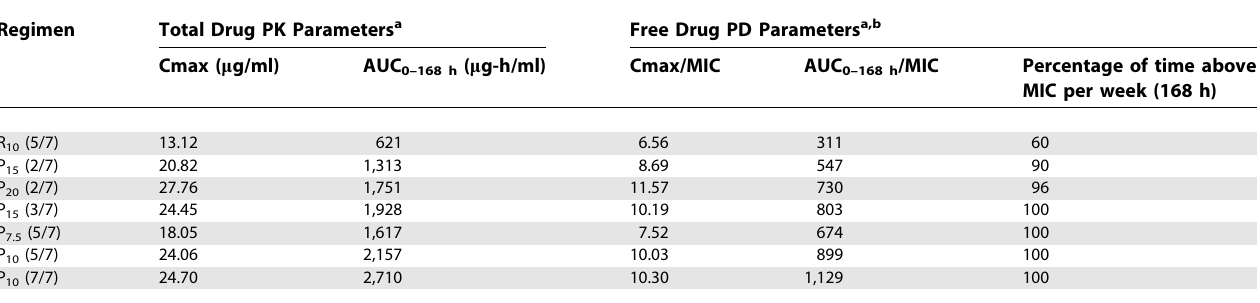
Table 3. Steady-State Pharmacokinetic and Pharmacodynamic Parameters for Rifapentine and Rifampin in Mice Regimen Total Drug PK Parameters